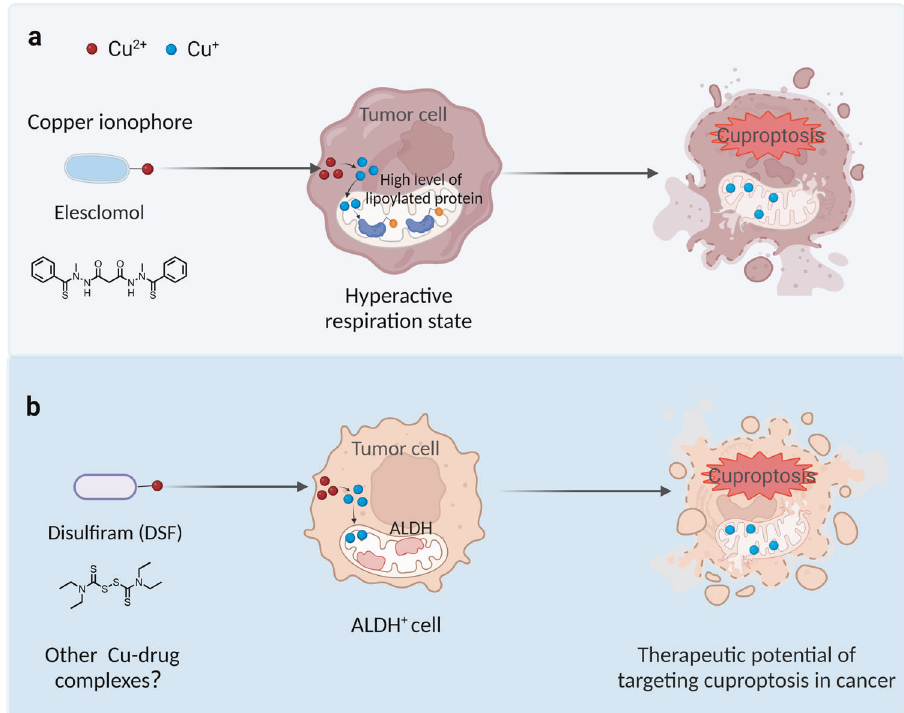
combined with Cu selectively targets cancer cells with high ALDH expression. Created with BioRender. ALDH aldehyde dehydrogenase, DSF disul fi